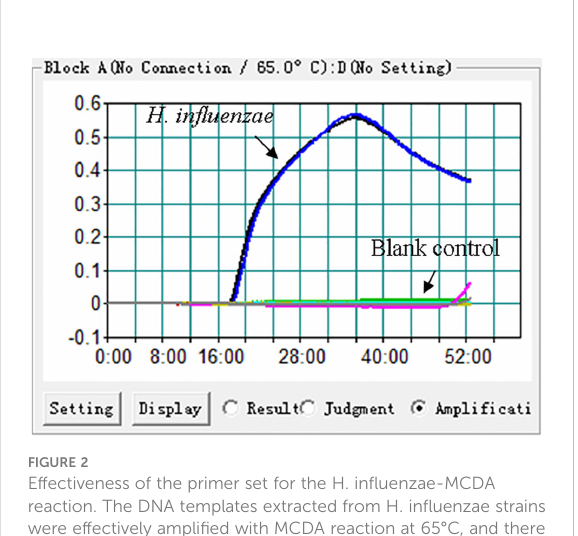
FIGURE 2 Effectiveness of the primer set for the H. in fl uenzae-MCDA reaction. The DNA templates extracted from H. in fl uenzae strains were effectively ampli fi ed with MCDA reaction at 65°C, and there is no reaction for the blank controls